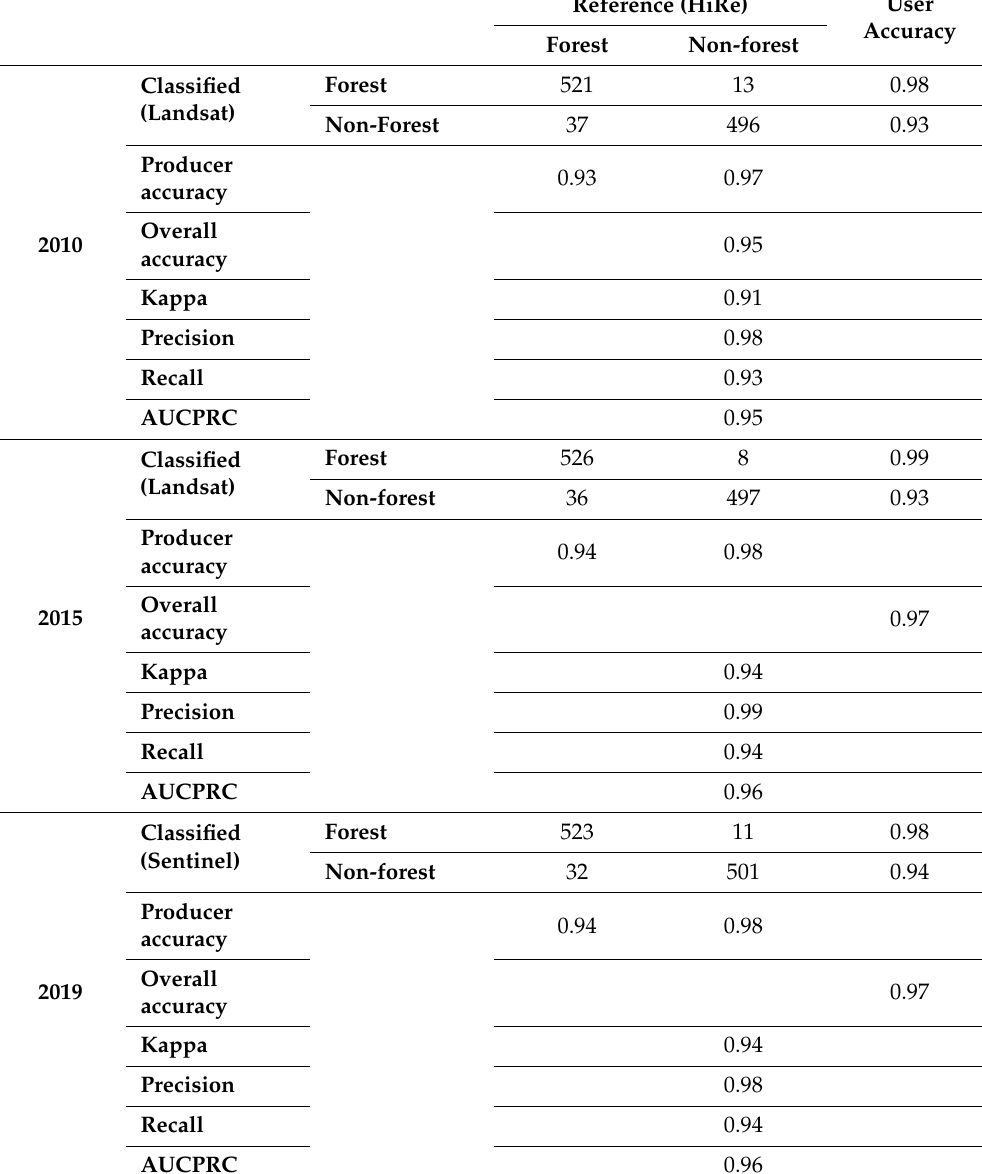
Table 2. Confusion matrix with two classes: forest and non-forest, for the years 2000, 2005 and 2019. AUCPRC: area under the curve of the precision-recall curve; HiRe: high-resolution panchromatic satellite